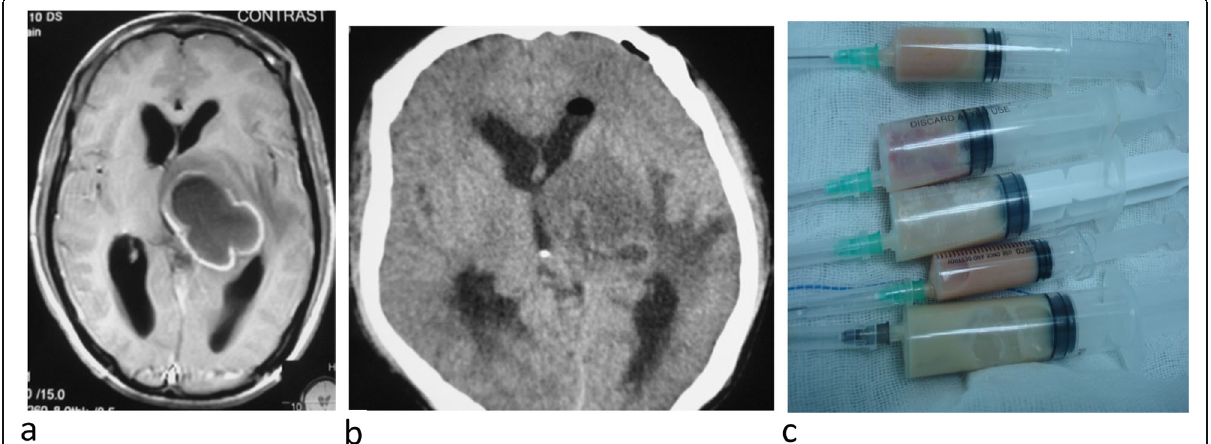
Fig. 5 a On the left MRI axial T1 with contrast showing left thalamic cyst and b on the right post stereotactic aspiration CT showing left thalamic cyst was aspirated, c below: aspirate was pus (cyst was an